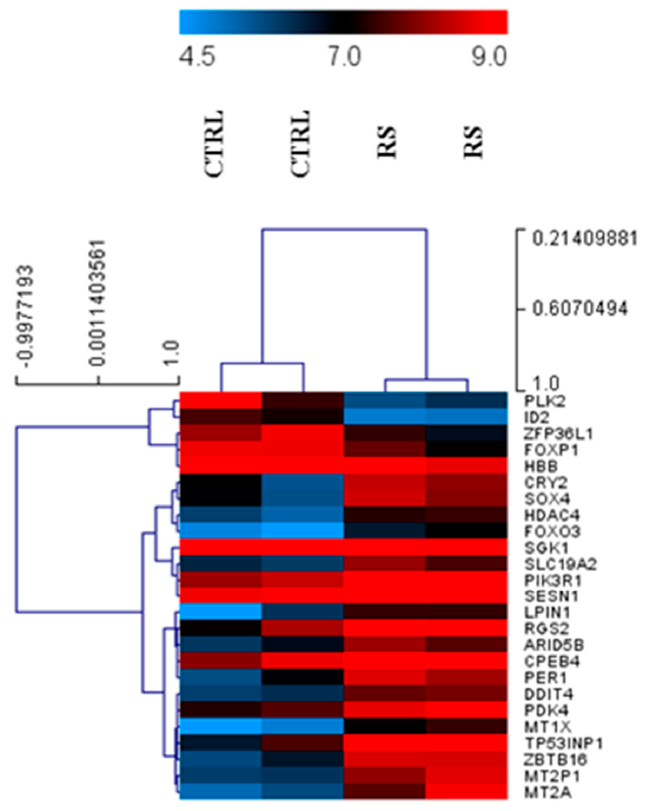
Figure 1. Heatmap of differentially expressed genes in pancreatic cancer tissue from the mice fed the control diet (CTRL) and the mice fed with the resistant starch (RS) diet.